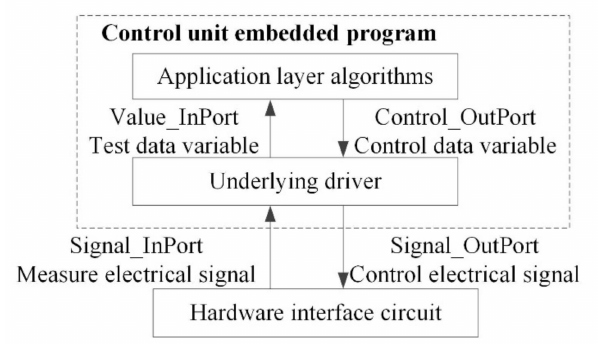
Figure 9. Structural relationships of embedded programs.